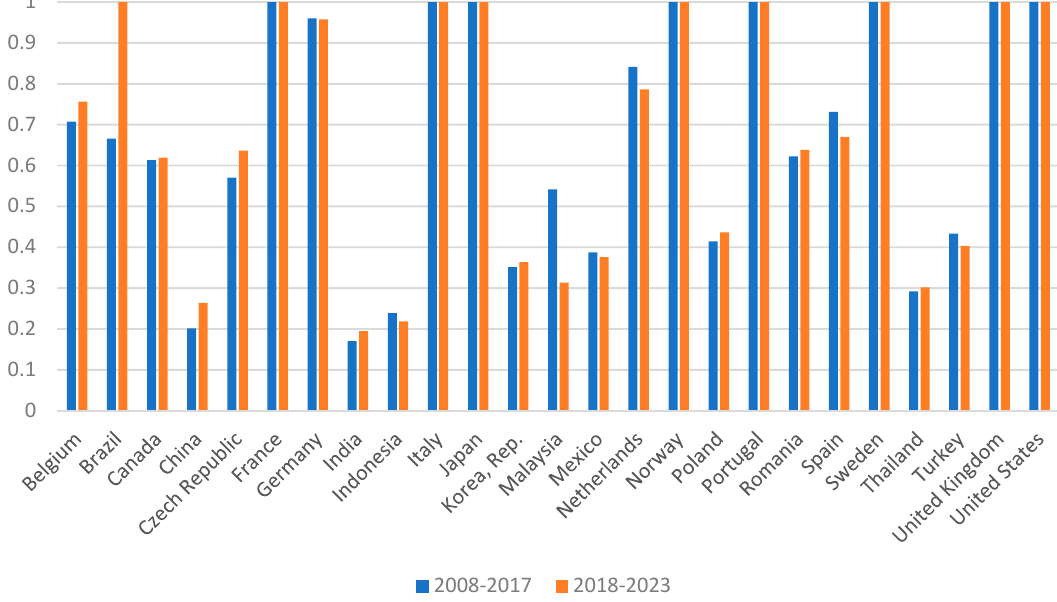
Figure 5. Energy-e ffi ciency score from 2008 to 2017 vs. 2018 to Figure 5. Energy-efficiency score from 2008 to 2017 vs. 2018 to 2023.